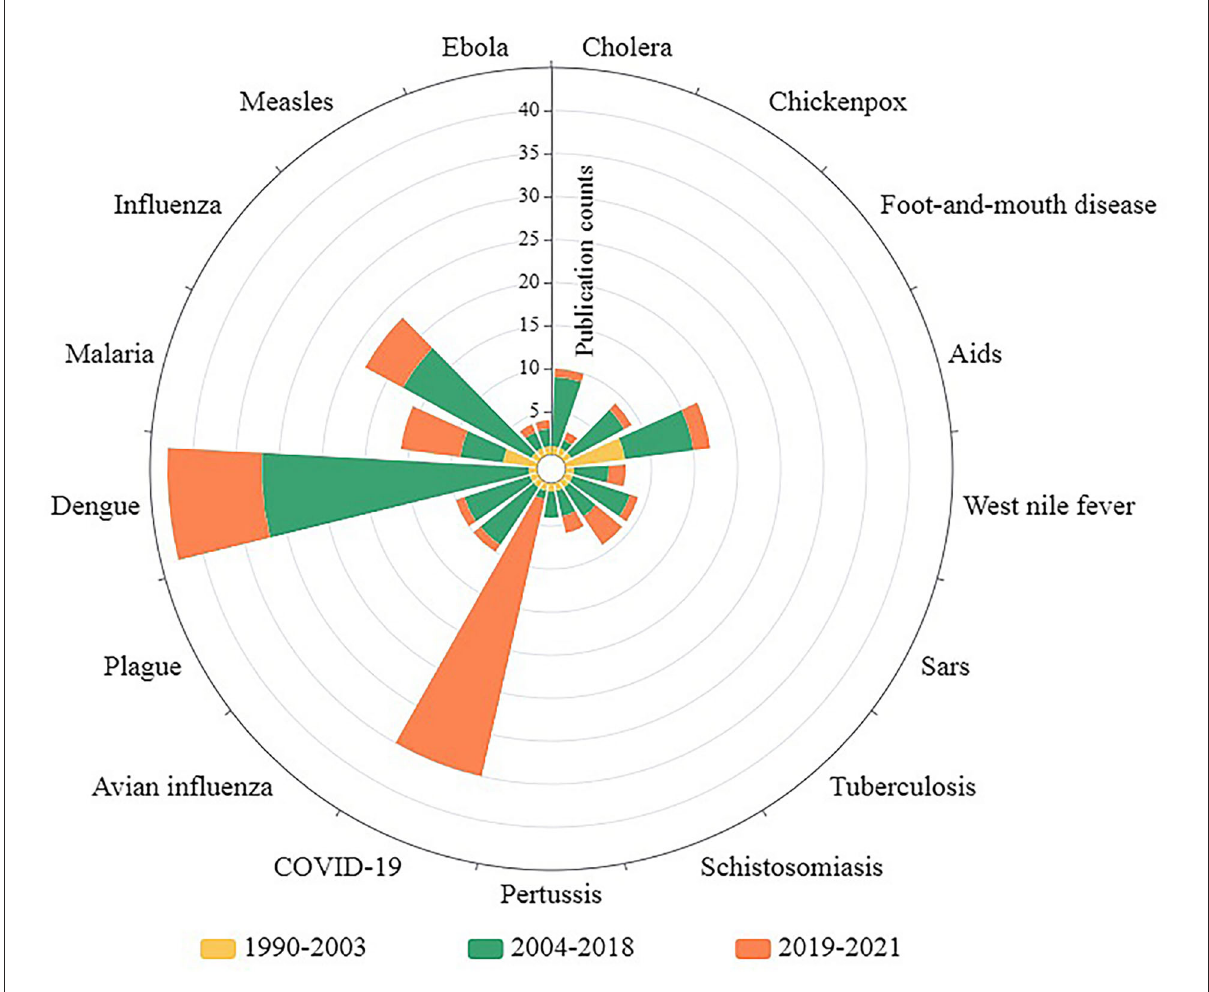
FIGURE3 Related publication counts of main infectious diseases by publication